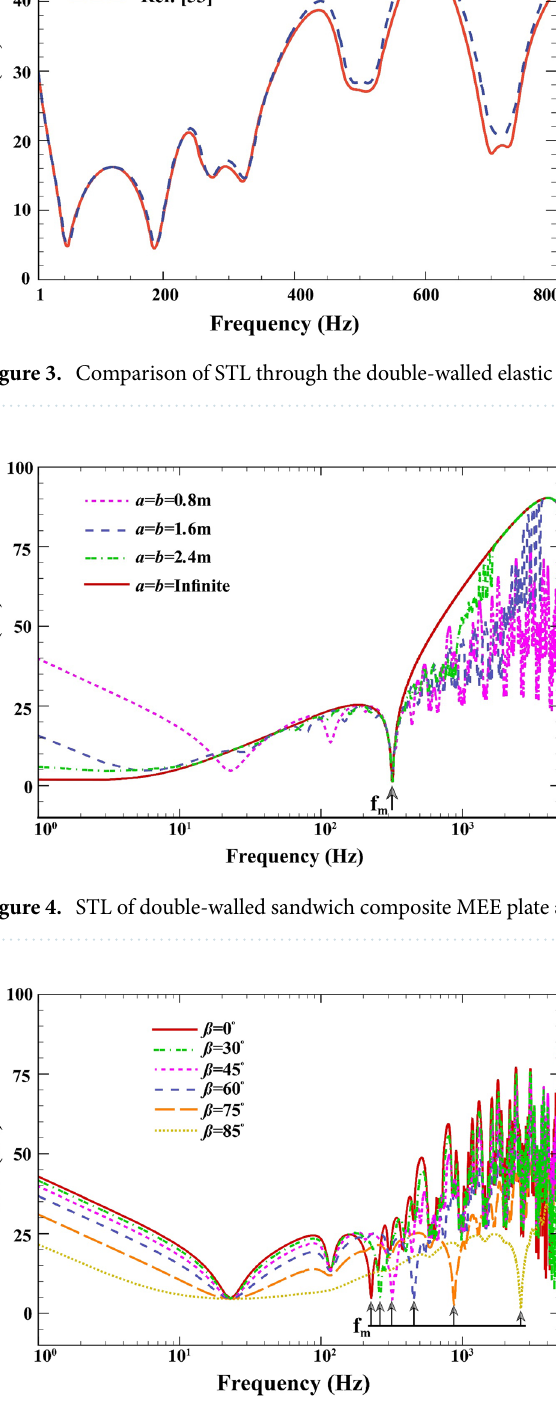
Figure 5. STL of double-walled sandwich composite MEE plate versus the elevation